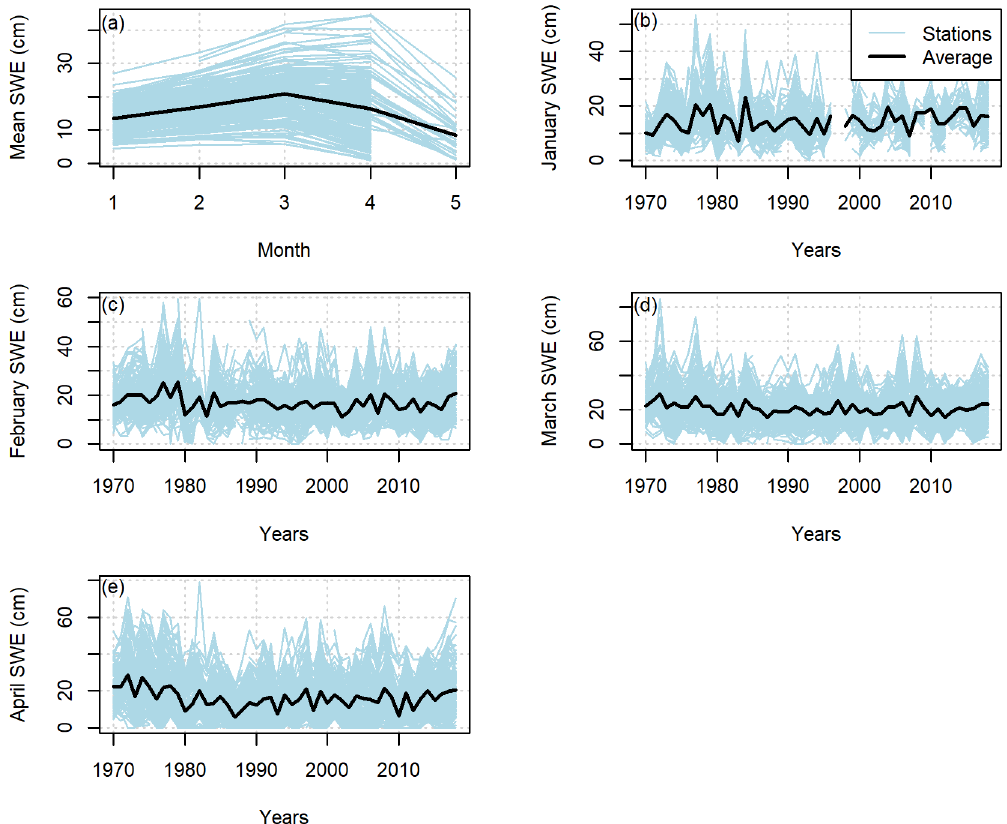
Figure 2. Averaged SWE observations in the study area between 1961 and 2018 (a) over the entire year, (b) in January, (c) in February, (d) in March and (e) in